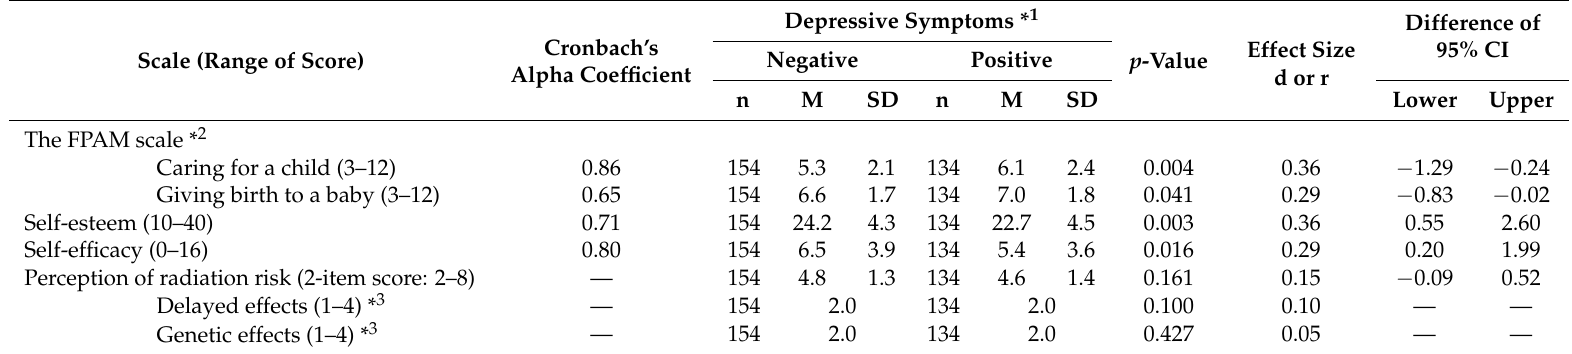
Table 2. Comparison of scale scores for depressive symptoms between the negative and positive groups.